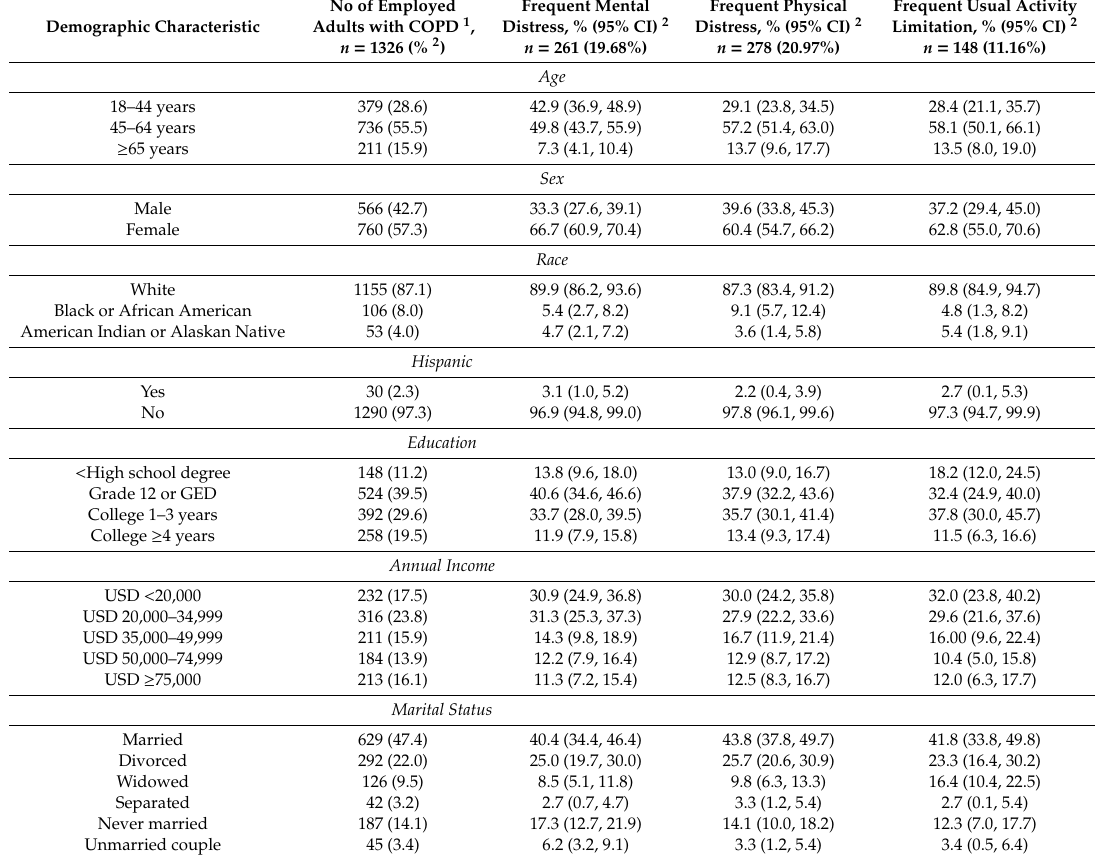
Table 1. Prevalence of frequent physical distress, mental distress, and activity limitation by demographic characteristics, employed adults with COPD, Behavioral Risk Factor Surveillance System, KY, NC, WV, and TN, 2016–2017 1